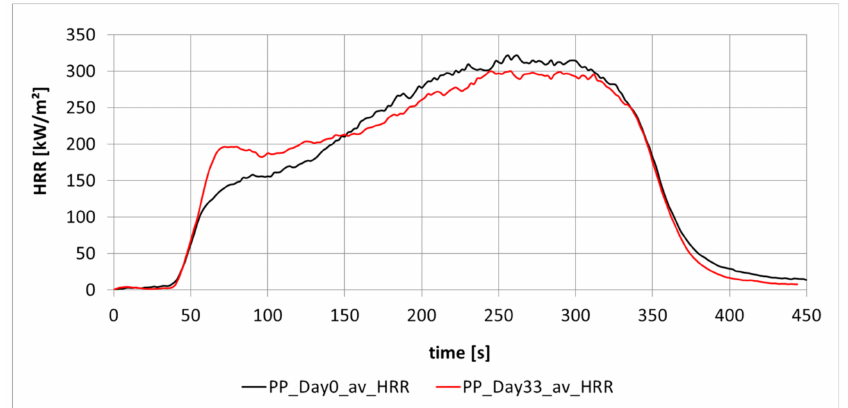
Figure 3. Heat release of PP (m = 20 g) produced by injection molding measured on the day of production and 33 days later.